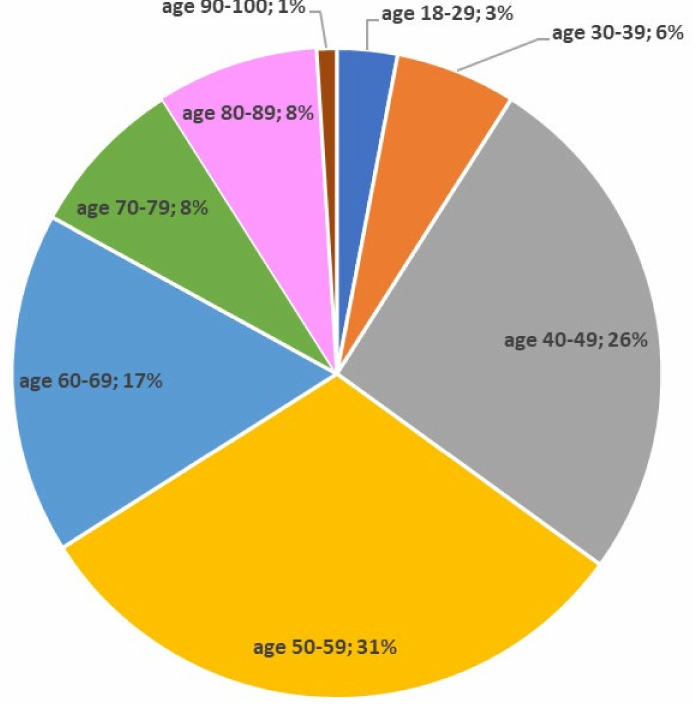
Figure 1. Age range of victims (n = 120).